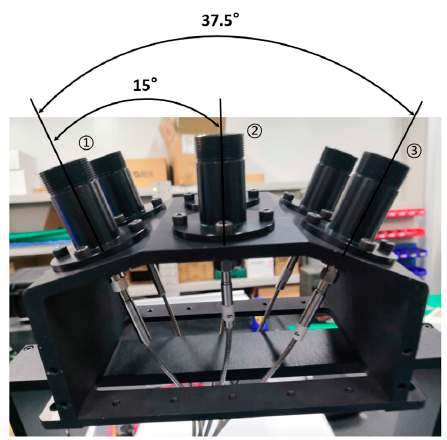
Figure 7. The positional relationship between six multi ‐ angle front telescopes (The position of ① in the figure corresponds to two direct solar channels, and the positions of ② and ③ correspond to four sky scattering channels).